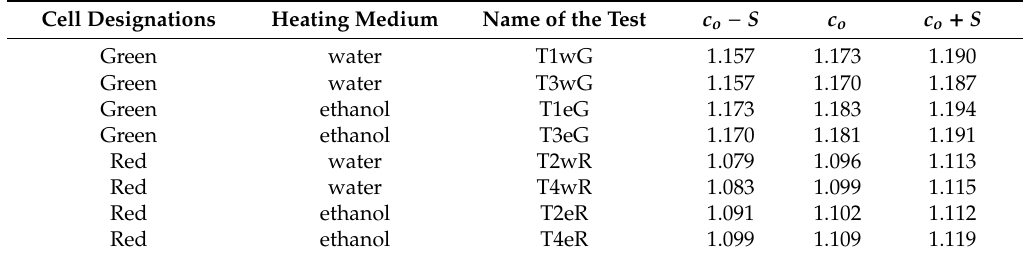
Table 6. List of the measurement results obtained in subsequent tests together with the standard